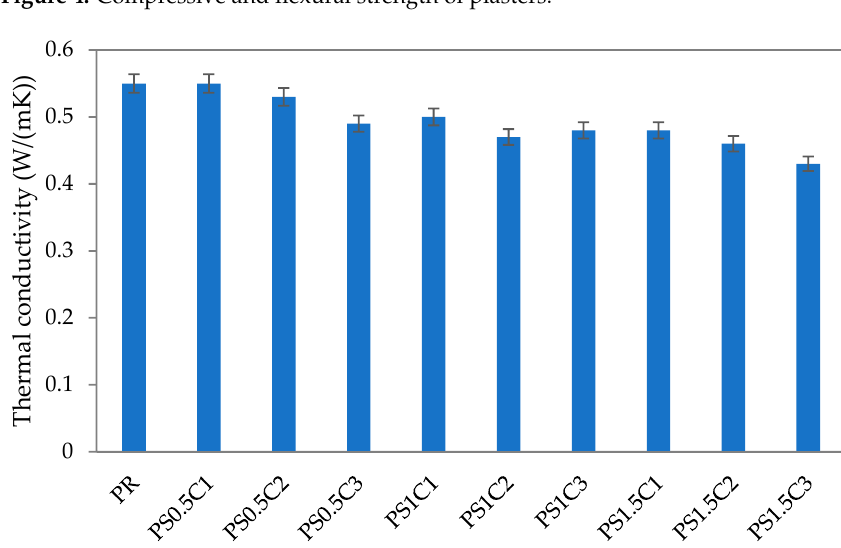
Figure 5. Thermal conductivity of studied materials.